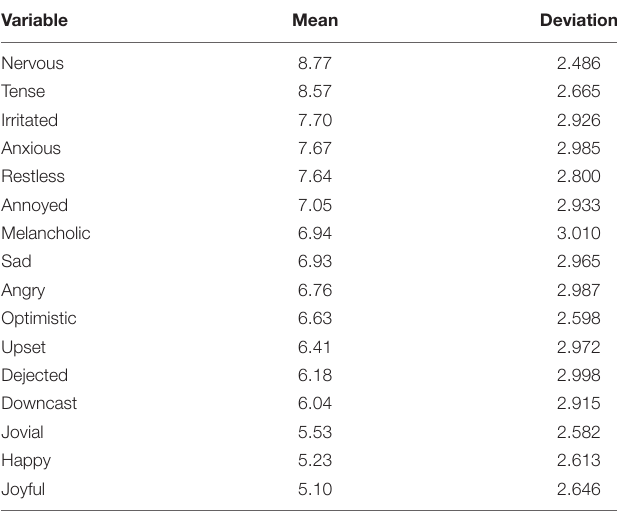
TABLE 2 | Impact of states of mind on teachers’ professional performance. Variable